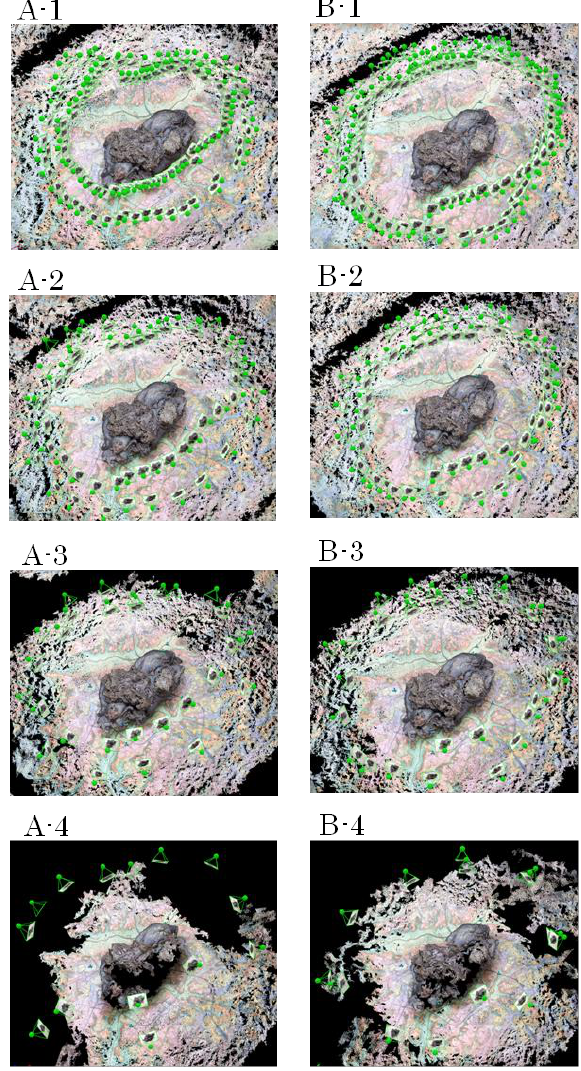
Figure 10. Point Clouds with reduced images Table 2. Data set name list of point